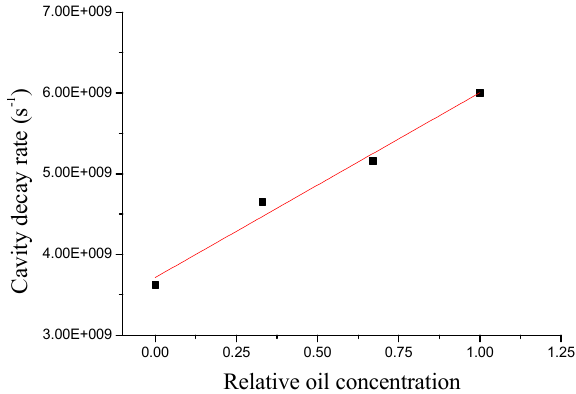
Figure 10. Photon decay rate for increasing olive-oil/seed-oil concentration levels (Reproduced with permission from permission from [27]).